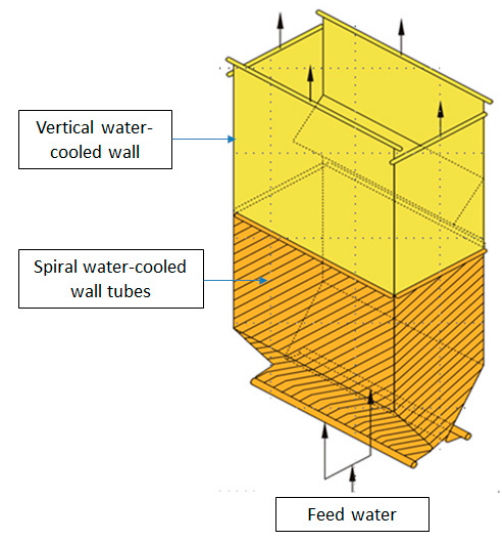
Figure 3. Spiral and vertical water-cooled wall inside the furnace.